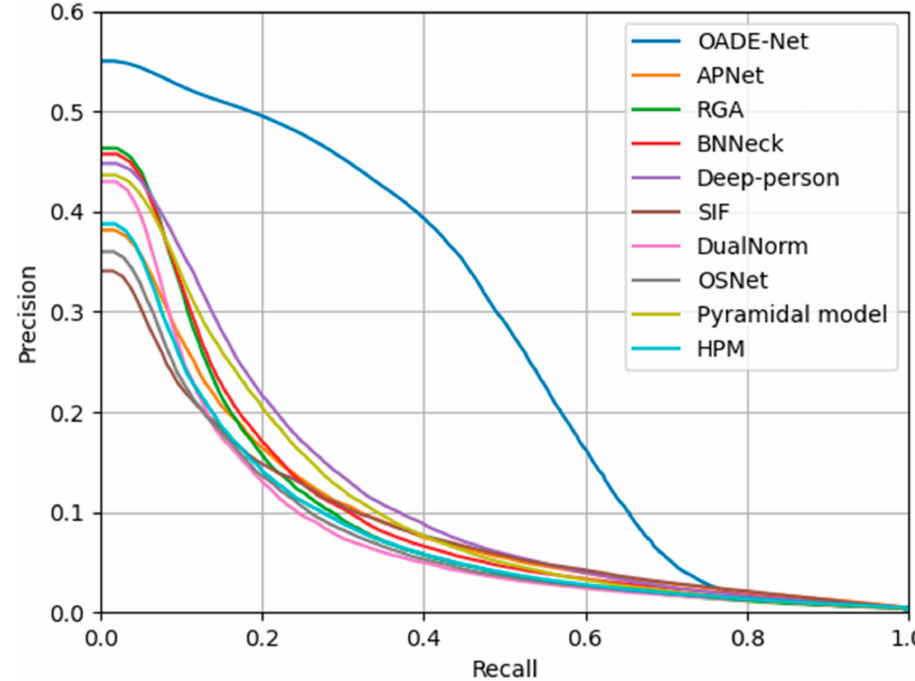
Figure 12. Graphs of precision versus recall of the proposed and state-of-the-art methods with